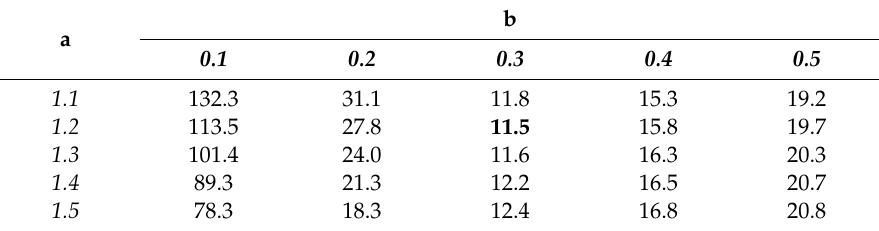
TableA1. Rootmeansquareerror(RMSE)ofthenumberoftreesmeasuredinthefieldagainstthenumber of trees from the model. The RMSE is calculated to optimize the tree crown area–height relationship. The table shows the RMSE for the linear function y = a + b ∗ Height. The rows indicate the parameter a and the columns parameter b. The RMSE is the most optimal with the function Crown area = 1.2 + 0.3 ∗ Height.